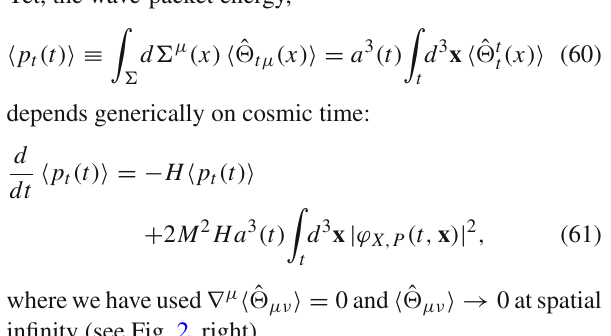
Fig. 2 Left: Numerical calculation of (cid:7) p z ( t ) (cid:5) . The solid straight line corresponds to the classical result (see Eq. (57b)). Right: Numeri- cal calculation of (cid:7) p t ( t ) (cid:5) . This plot shows (cid:7) p t ( t ) (cid:5) / p t ( t ) , where p t ( t ) corresponds to the classical energy (Eq. (57a)) with P replaced by